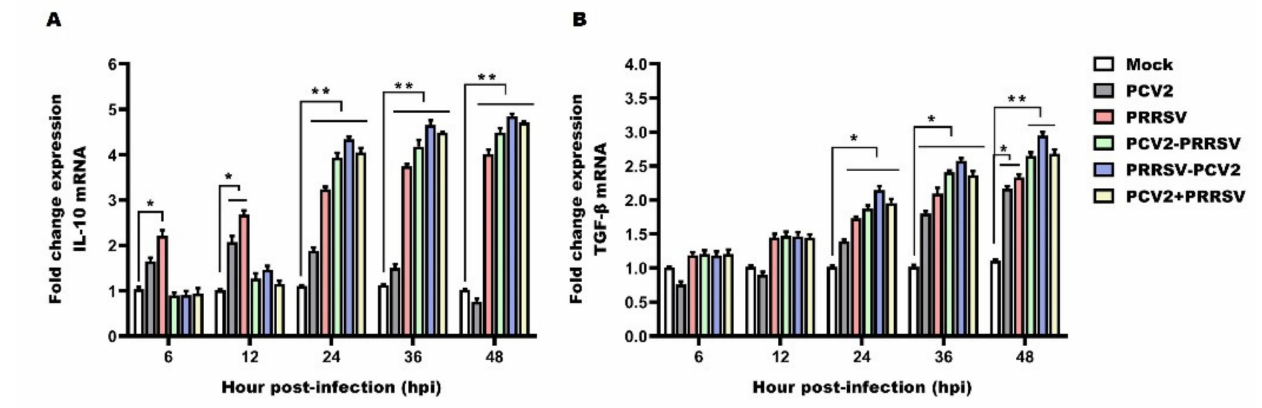
Figure 6. Relative mRNA expression of IL-10 and TGF- β . PAMs in the PCV2 alone group (PCV2), the PRRSV alone group (PRRSV) and the PCV2 and PRRSV co-infected groups (PCV2–PRRSV, PRRSV– PCV2 and PCV2 + PRRSV) were inoculated with PRRSV and/or PCV2 at a MOI of 1, respectively. PAMs in the mock group were inoculated with equal RPMI-1640 medium. Then, PAMs in these groups were collected at 6 h, 12 h, 24 h, 36 h and 48 h post-infection, respectively. RT-qPCR analysis of TNF- α ( A ) and IL-1 β ( B ) mRNA in PAMs from different groups. Data are expressed as means ± SD of three independent experiments. Significant differences between groups are represented (** p < 0.01, * p <